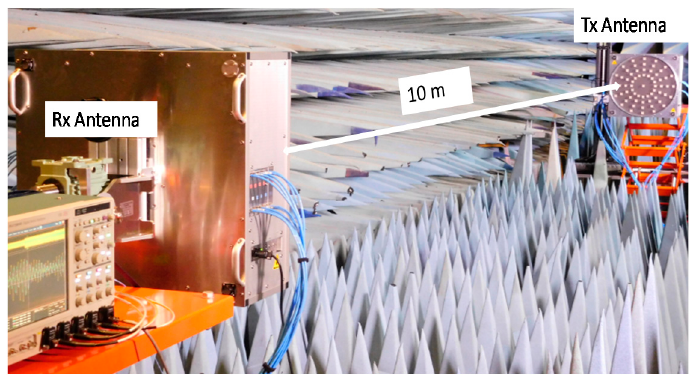
Figure 10. Experimental environment (OAM-MIMO multiplexing). Table 4. Experimental parameters (OAM-MIMO multiplexing).